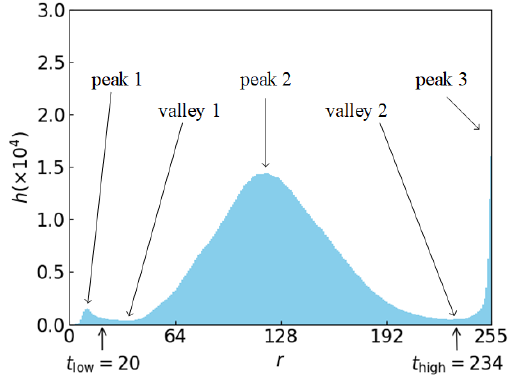
Figure 4. Smoothed histogram of the grabbed ROI.